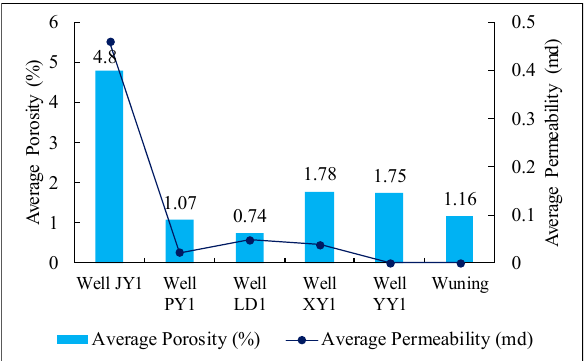
Figure 6. Comparison of the porosity and permeability between the Xinkailing-formation shale in Wuning and the Longmaxi-formation shale in the middle-upper Yangtze area.